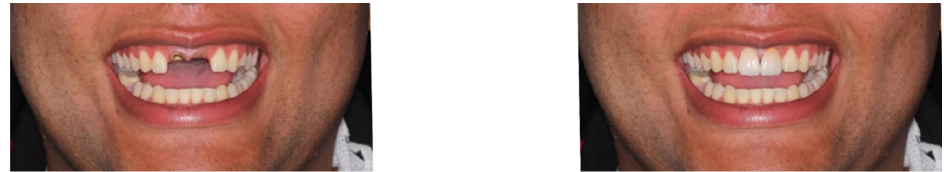
Figure 3. Reverse treatment photo of elements #21 and #11 via DSD program.